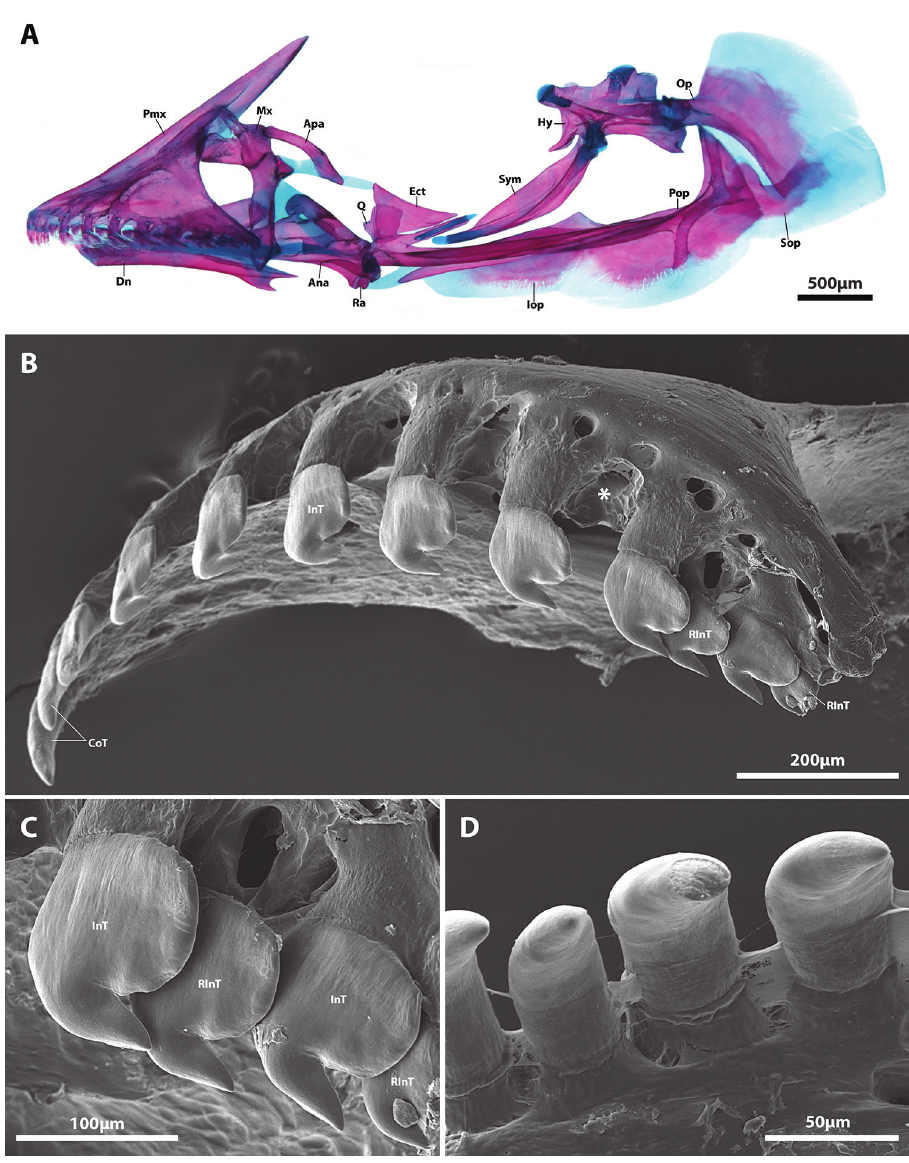
Figure 7. Flexor incus, AIM MA655142, paratype, 20.0 mm SL. A Hyopalatine arch and opercular series, right side in lateral view (image reversed) B Scanning electron micrograph of premaxilla, right side in oblique lateral view (image reversed). Asterisk (*) highlights location of replacement tooth crypt C Close up of posteriormost incisiviform teeth of premaxilla shown in A D Scanning electron micrograph of conical teeth located close to middle of dentary, right side in medial view (image reversed). Abbrevia- tions: Ana, anguloarticular; Apa, autopalatine; CoT, conical tooth; Dn, dentary; Ect, ectopterygoid; Hy, hyomandibular; InT, incisiviform tooth; Iop, interopercle; Mx, maxilla; Op, opercle; Pop, preopercle; Q, quadrate; Ra, retroarticular; RInT, replacement incisiviform tooth; Sop, subopercle; Sym,